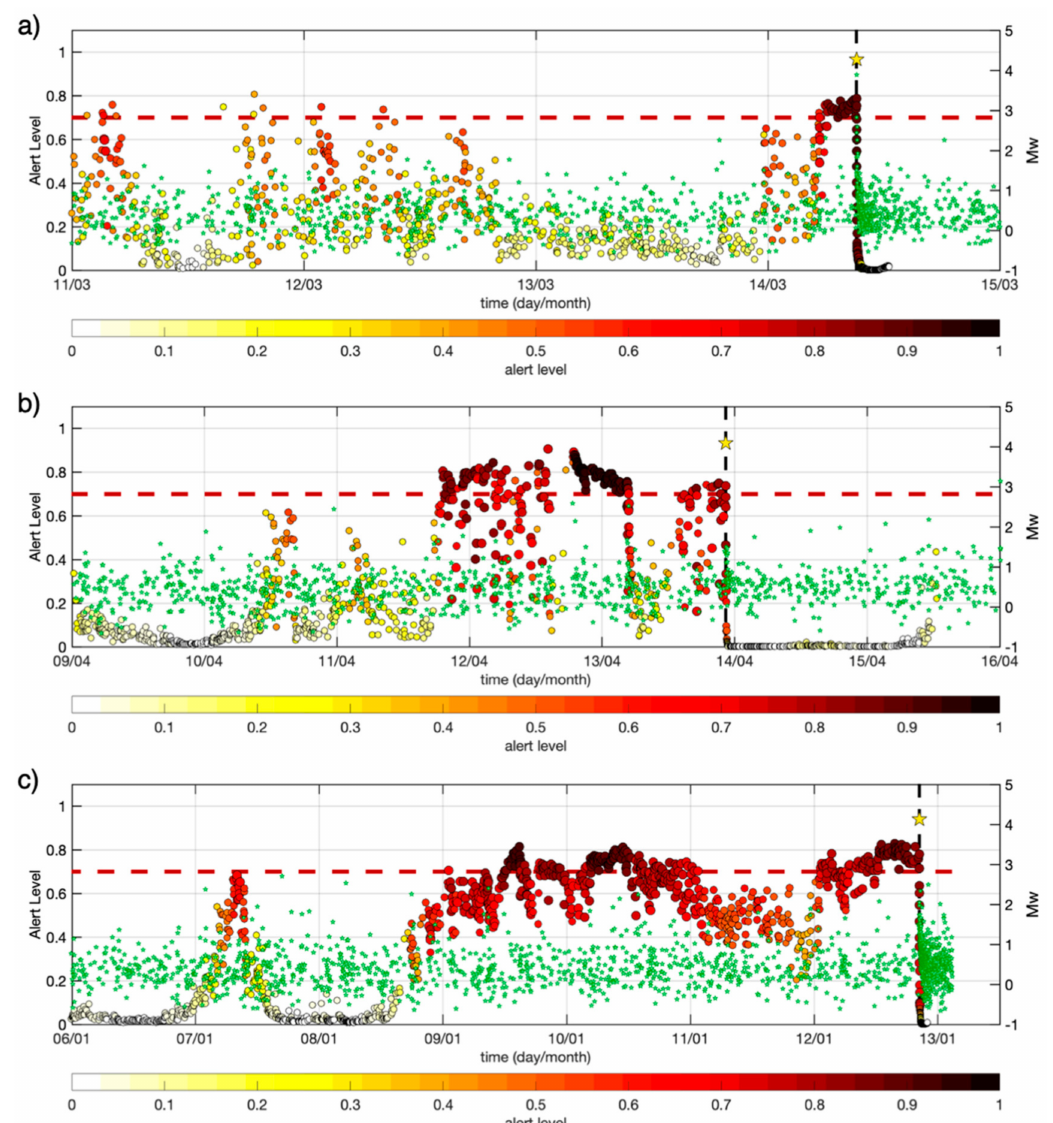
Figure 7. Application of RNN1 and RNN2 combined into a prototype of alert system to the three M4 testing series. ( a ) Distribution of event magnitude in time (green stars and right-side y -axis) for the M4 that occurred on the 14th March 2013 (yellow star). The threshold alert level (dashed red line) and alert probability (P ALERT ) refer to the left-side y -axis. P ALERT are dots colored and with size varying according to their values (i.e., from white, no alert, to dark red for events above the threshold alert level). ( b ) The same as ( a ), but for the M4 that occurred on the 14th April 2013. ( c ) The same as ( a ), but for the M4 that occurred on the 13th January